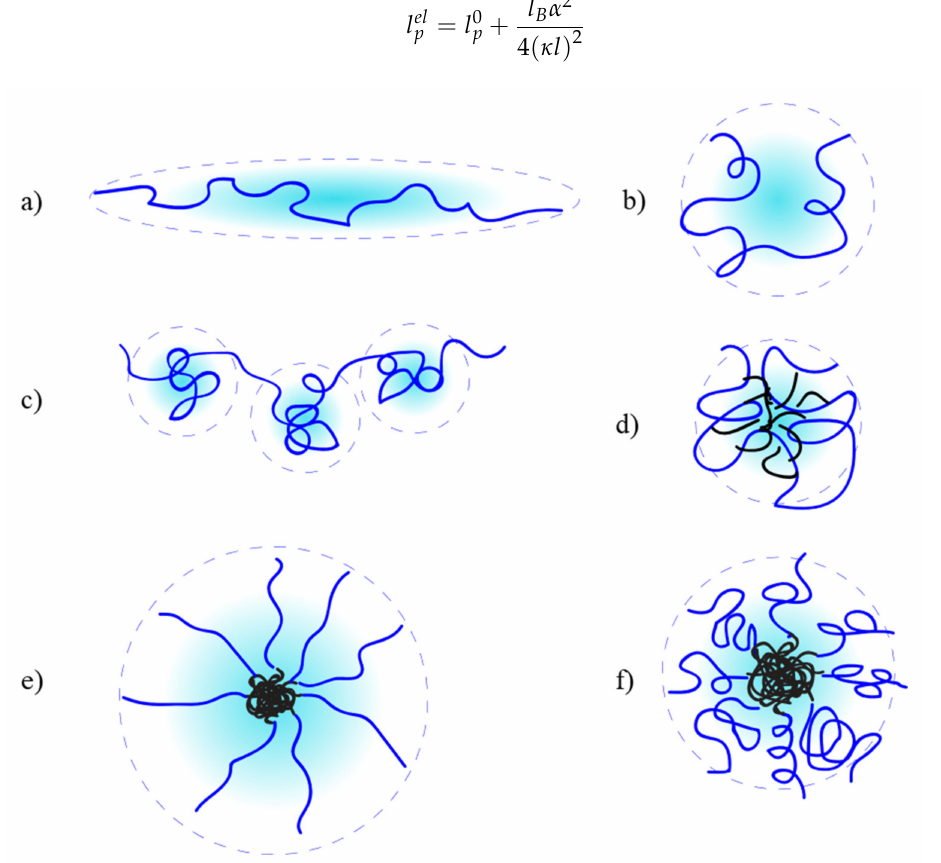
Figure 1. Conformation of various kind of PE in solution: ( a ) salt-free conditions; ( b ) in saline water; ( c ) pearl-necklace model for hydrophobic PE; ( d ) globule conformation for highly hydrophobic PE; ( e ) amphiphilic block polyelectrolytes (ABPE) in salt-free conditions; ( f ) APBE in saline